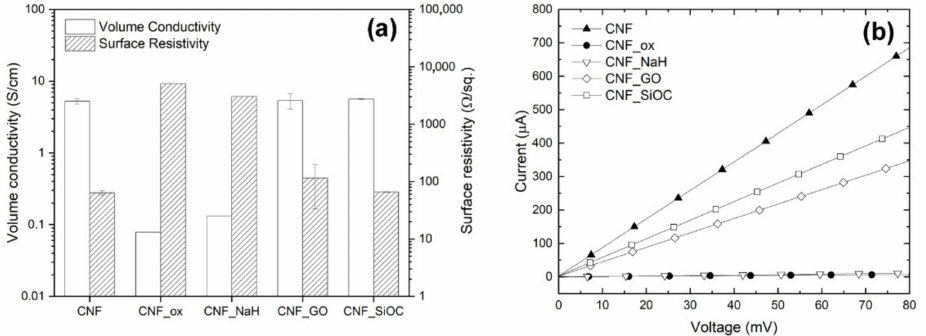
Figure 8. ( a ) Volume conductivity and surface resistivity of various types of modified carbon nanofibers. ( b ) Corresponding current-voltage